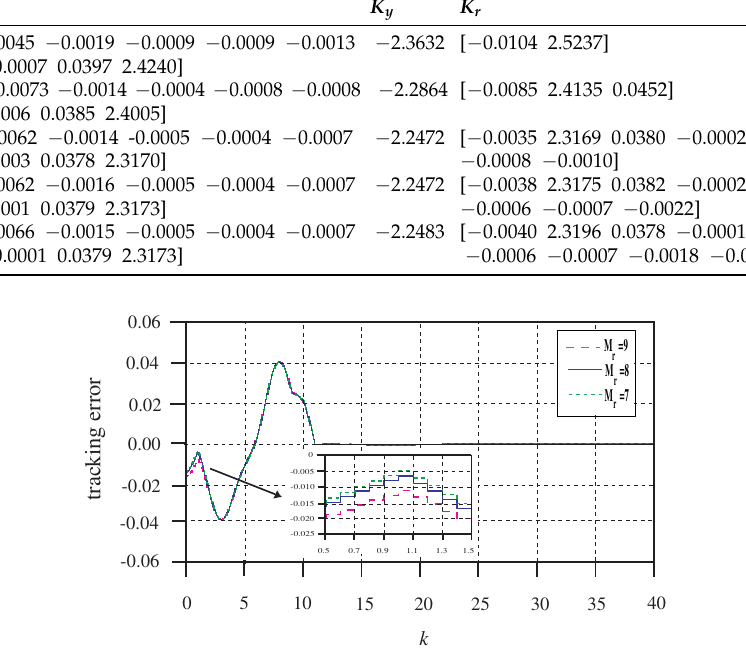
Figure 7. The tracking errors with different preview length of M r